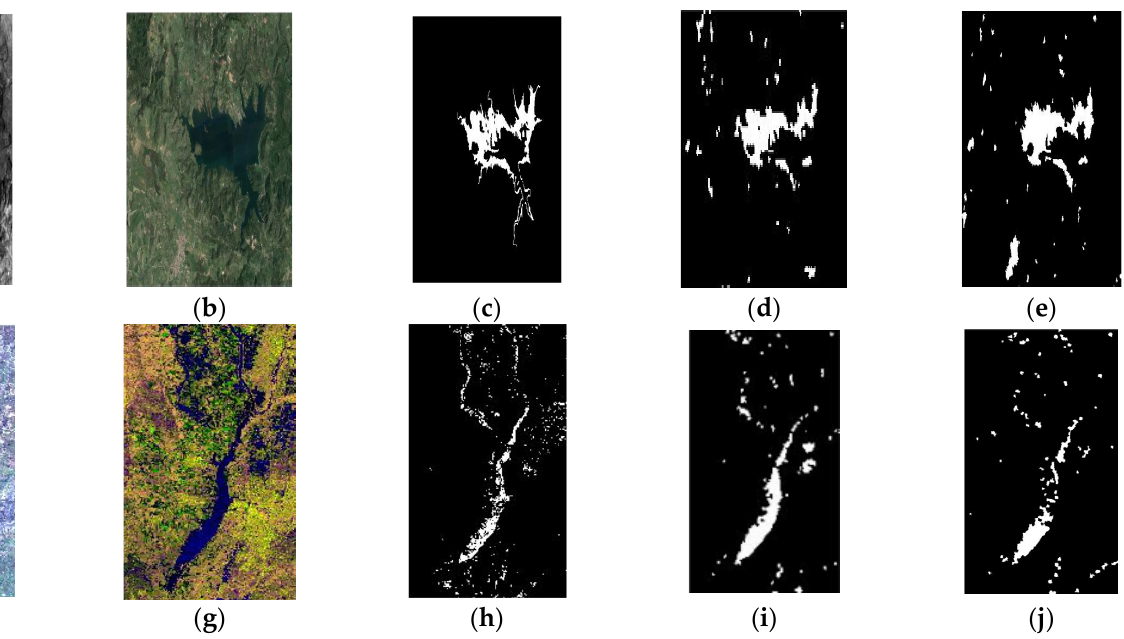
Figure 6. Performance comparison: ( a ) pre-event of Italy; ( b ) after-event of Italy; ( c ) ground truth of Italy; ( d ) self-constructed network of Italy; ( e ) our proposed method with modification of Italy; ( f ) pre-event of California; ( g ) after-event of California; ( h ) ground truth of California; ( i ) self-constructed network of California; ( j ) our proposed method with modification of California. Table 7. The performance comparison for Italy to show the effectiveness of feature extraction part. AUC